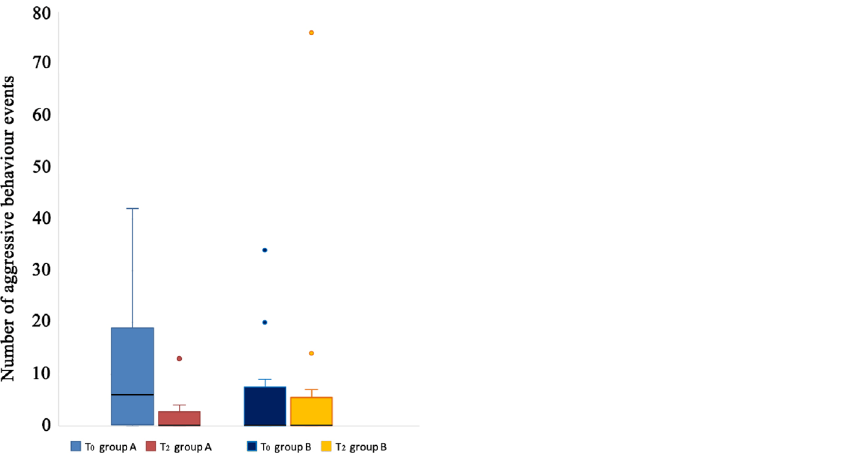
Figure 3. Difference in aggressive behaviour towards humans at different times (T 0 = before the start of the experiment and T 2 = 45 days from the start of the experiment) for dogs treated with cannabidiol (CBD) and dogs in the control group (receiving olive oil as a placebo). The black bars within the box plots indicate the median; the dots represent the outliers.